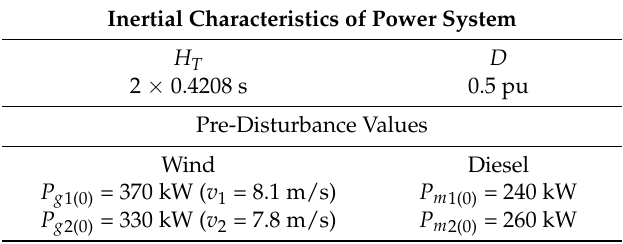
Table 2. SCHPS real contingency